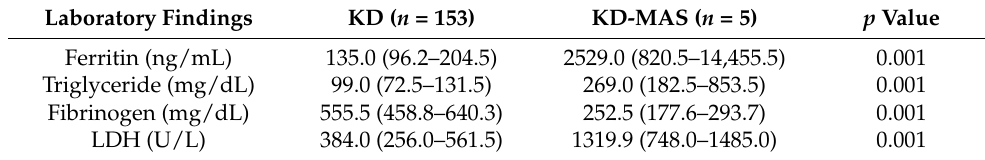
Table 3. Detailed laboratory findings of two groups on the first day of admission. Laboratory